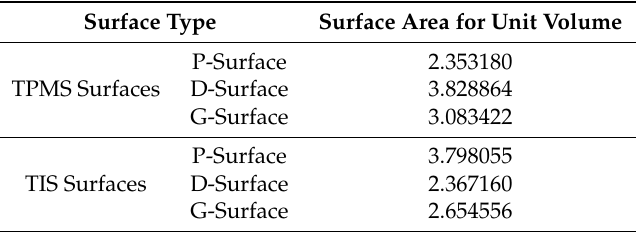
Figure 11. Distribution maps of the mean curvature and corresponding histograms for TPMSs and TISs. Table 4. Surface areas of TPMSs and TISs for a unit volume.